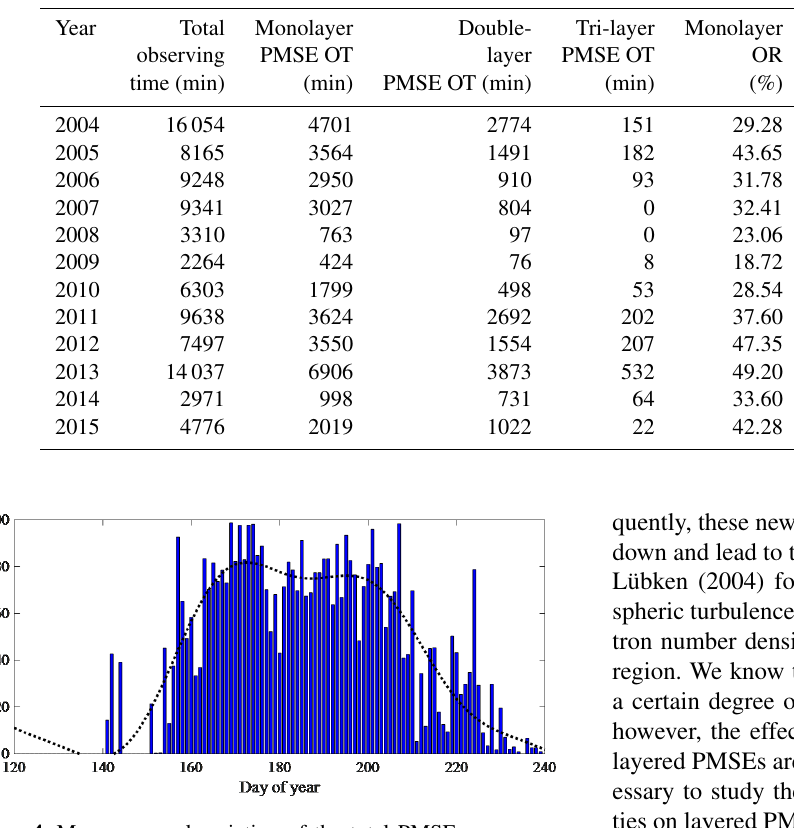
Figure 4. Mean seasonal variation of the total PMSE occurrence